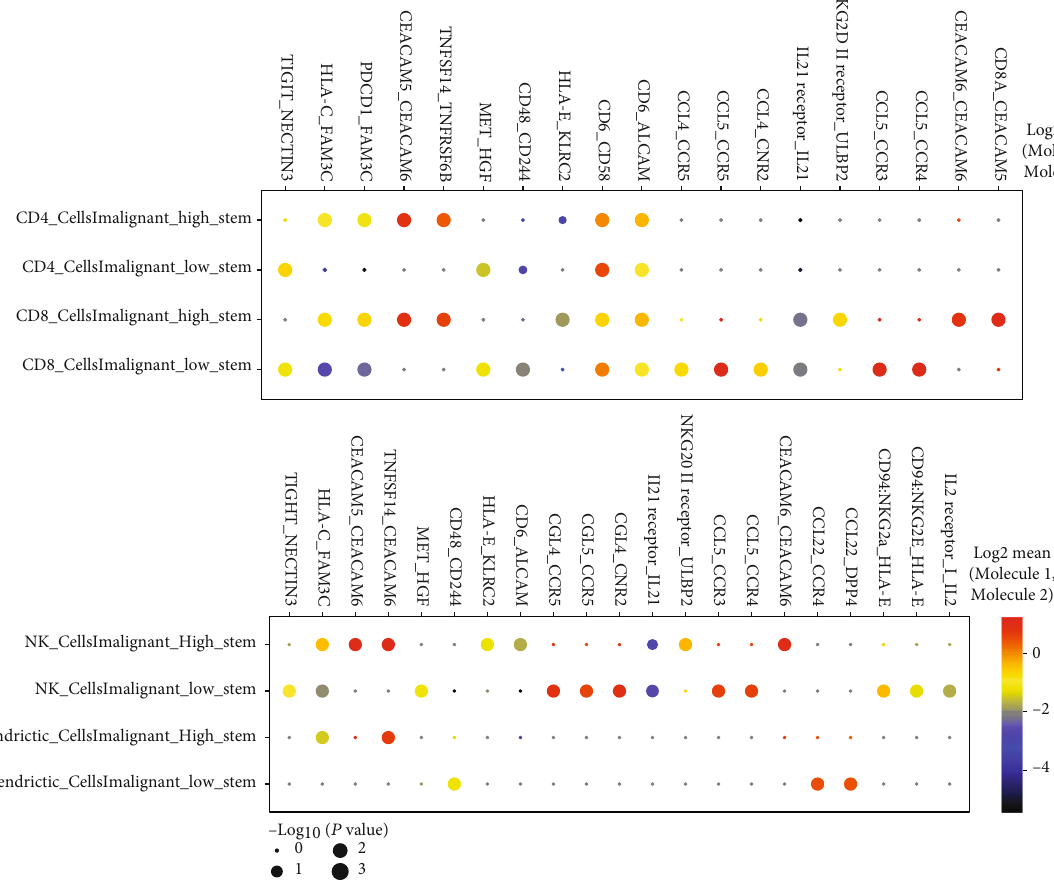
Figure 6: Communication between malignant cells and immune cells. Dot plot showing top predicted ligand-receptor interactions of malignant cells and T cells (upper panel) and malignant cells and NK/myeloid/dendritic cells (lower panel). Column represents ligand and receptor pairs. Red, ligand from malignant cells; blue, receptor from immune cells. Row represents pair of malignant cells (red) and immune cell subtype